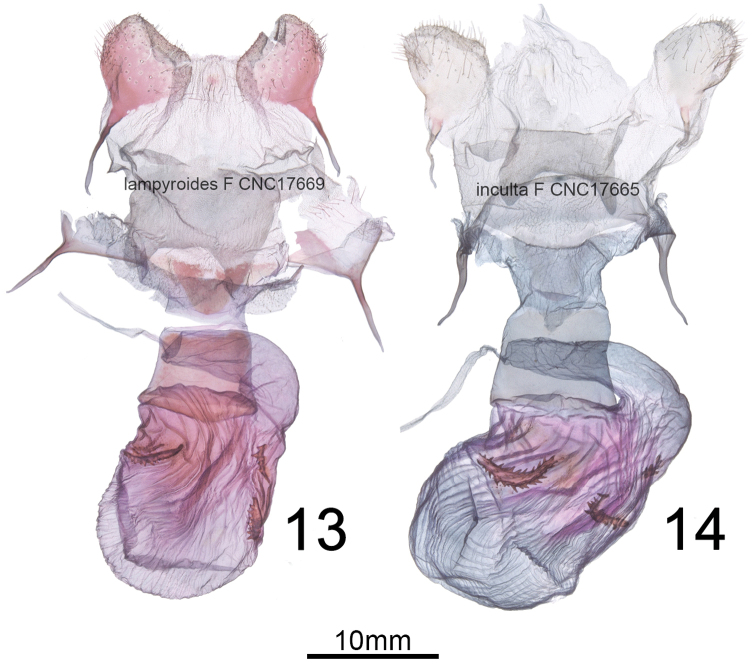
Female genitalia of 13Hypoprepiainculta and 14Hypoprepialampyroides.